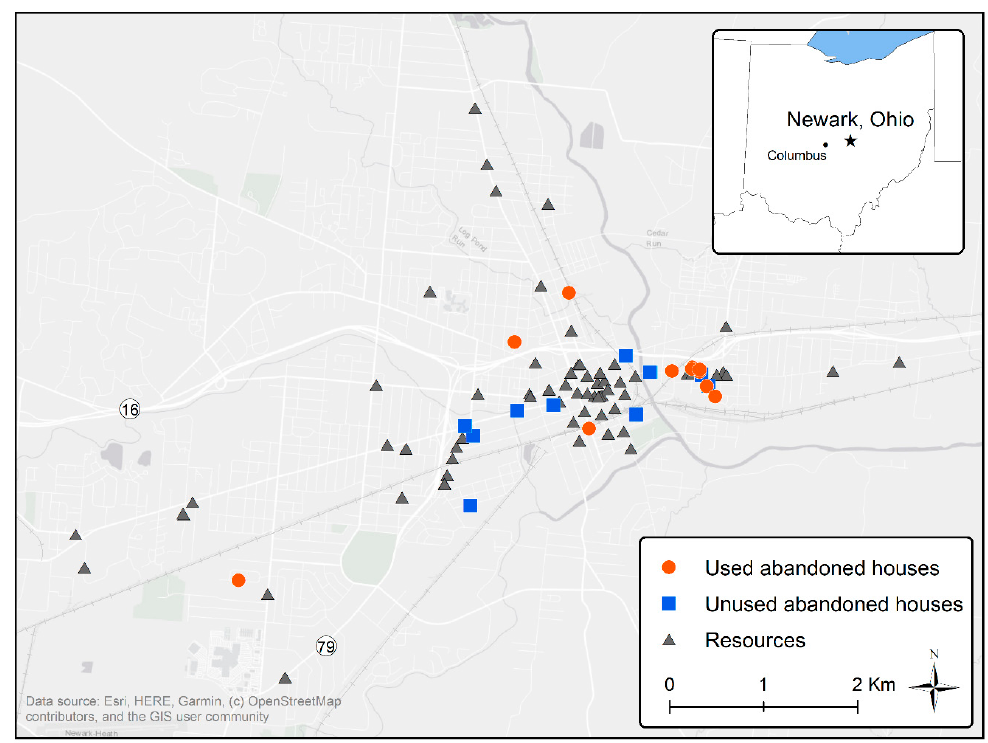
Figure 1. Location of twenty-two abandoned houses examined in Newark, Ohio, including structures utilized (red circles) and not utilized (blue squares) by homeless persons. Triangles indicate locations of resources included in the analyses.